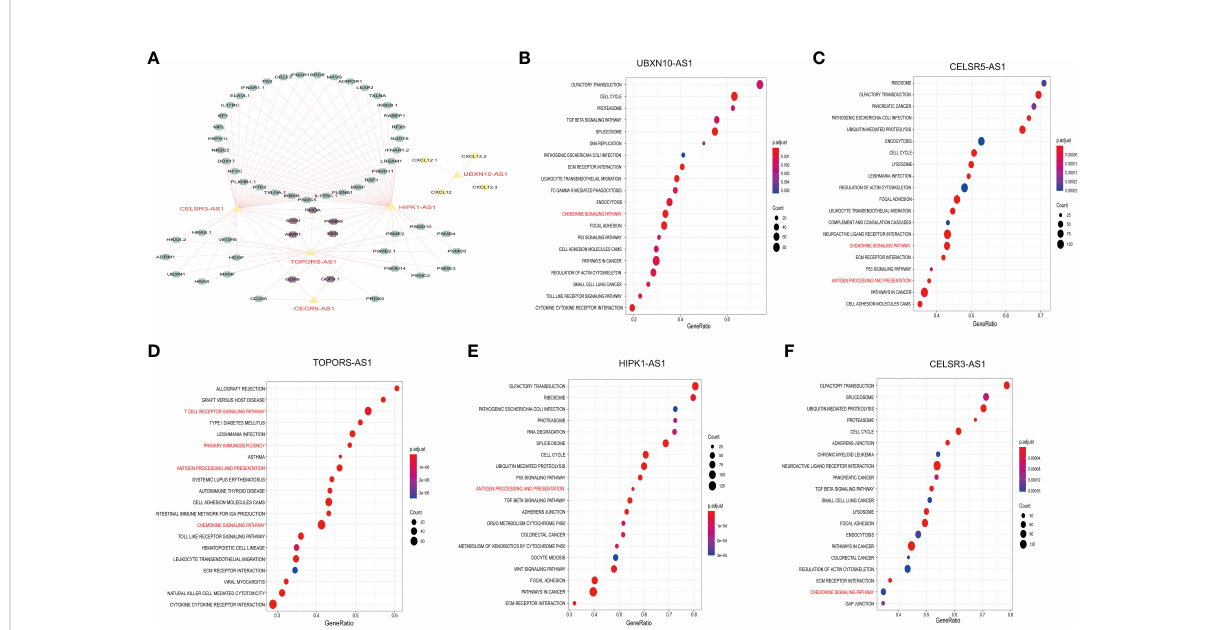
FIGURE 7 Exploration of the fi ve immune-related lncNRAs function. Construction of the co-expression network of the fi ve immune-related lncRNAs and immune-related mRNA (A) . GSEA assay to explore the pathways associated with the fi ve immune-related lncRNAs (B-F)